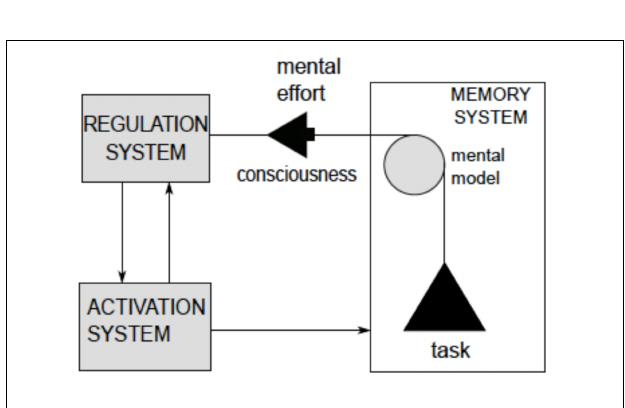
FIGURE 16 | Adapting to world streams involves work performed by regulatory system on a memory system. Mental models are neuronal structures amplifying the brain’s capacity to handle challenging tasks (non-contiguous stimuli, acting on objects to impact other objects, etc.) within a limited energy budget (Raichle and Gusnard, 2002) (question “who is pulling the rope in the pulley?” will be entertained elsewhere).